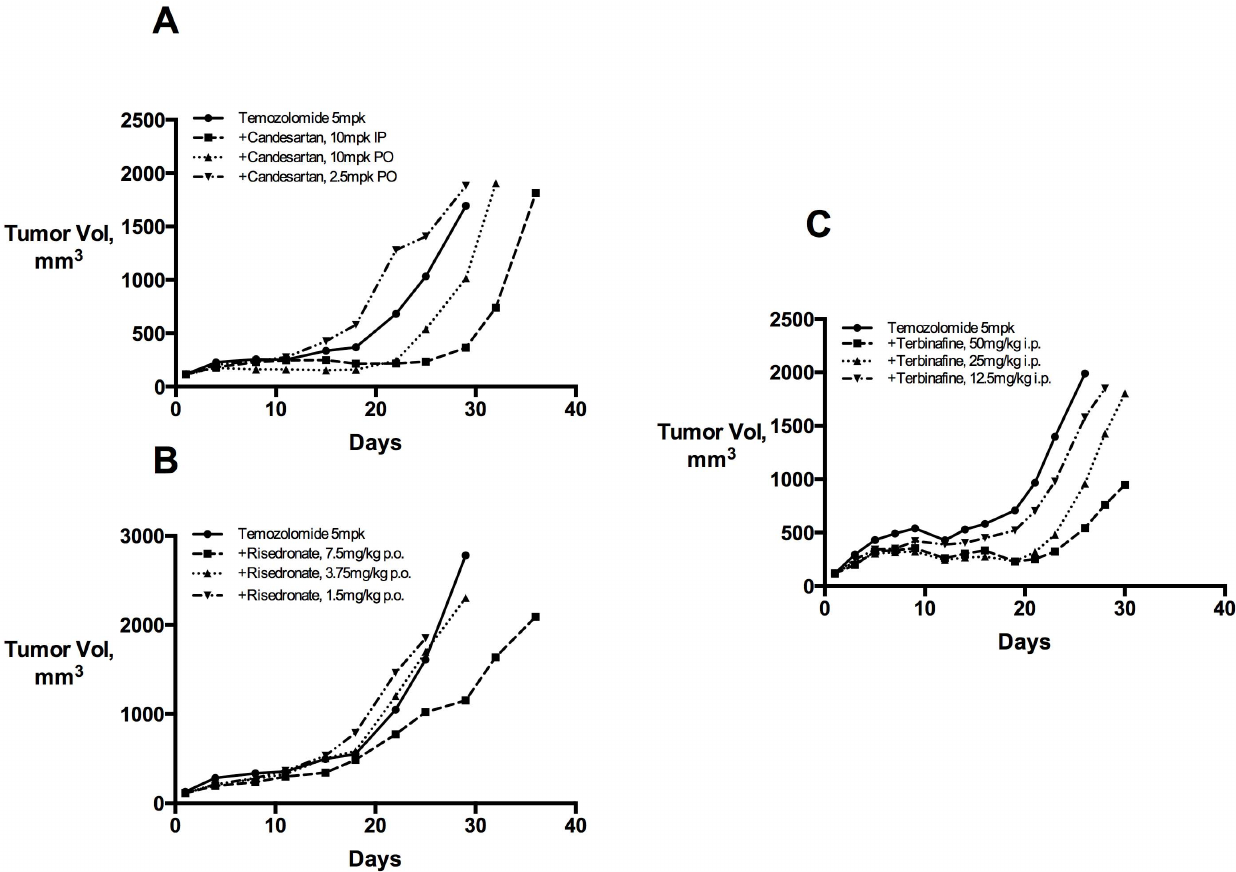
Figure 3. A. Candesartan dose range confirmation in the U87-MG model. Candesartan was confirmed at its screening dose and route; efficacy diminished following oral administration near and below the stated MTD dose equivalent of 14.3 mg/kg. B. Risedronate dose range confirmation. Risedronate exhibited modest combination effects when dosed orally at 7.5 mg/kg, which near MHRDD dose equivalent of 5 mg/kg (compare to screen result at 15 mg/kg, i.p.). The dose exposure trend was modest, and appeared equivalent at doses slightly below 5 mg/kg. C. Terbinafine dose range confirmation. Terbinafine was tested by i.p. administration. Efficacy diminished as drug was administered below the human dose equivalent of 4 mg/kg. Group means shown; cohort SEM not shown for